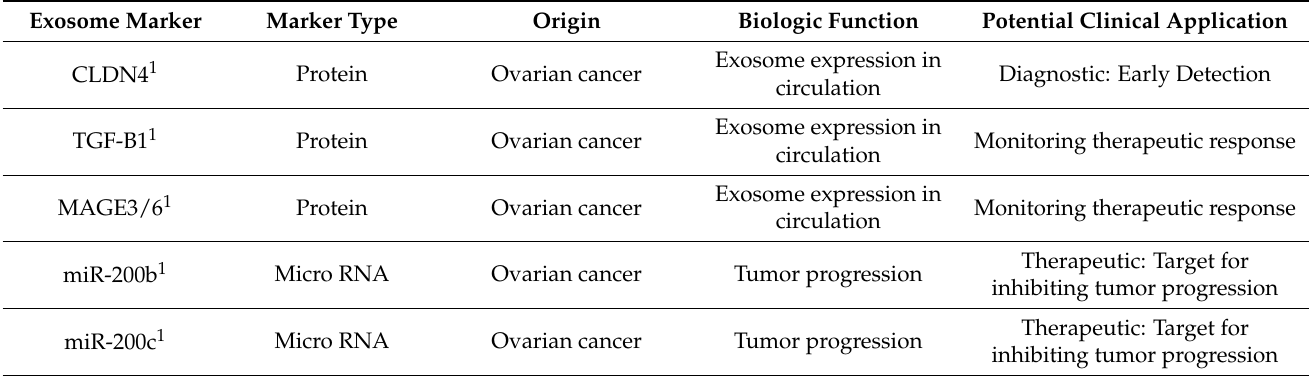
Table 2. Exosome markers identified in gynecologic